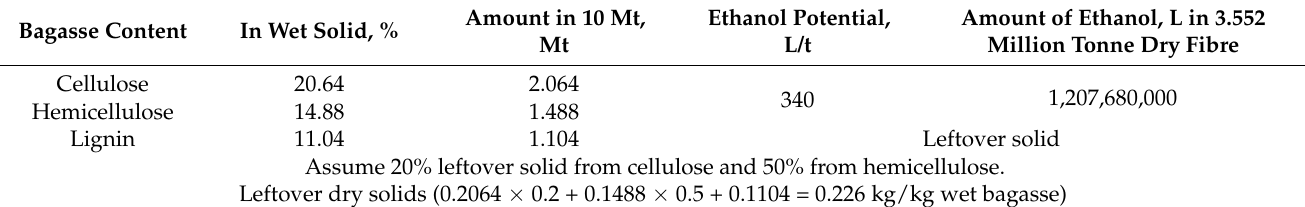
Table 10. Potential of ethanol production from bagasse in Australia.